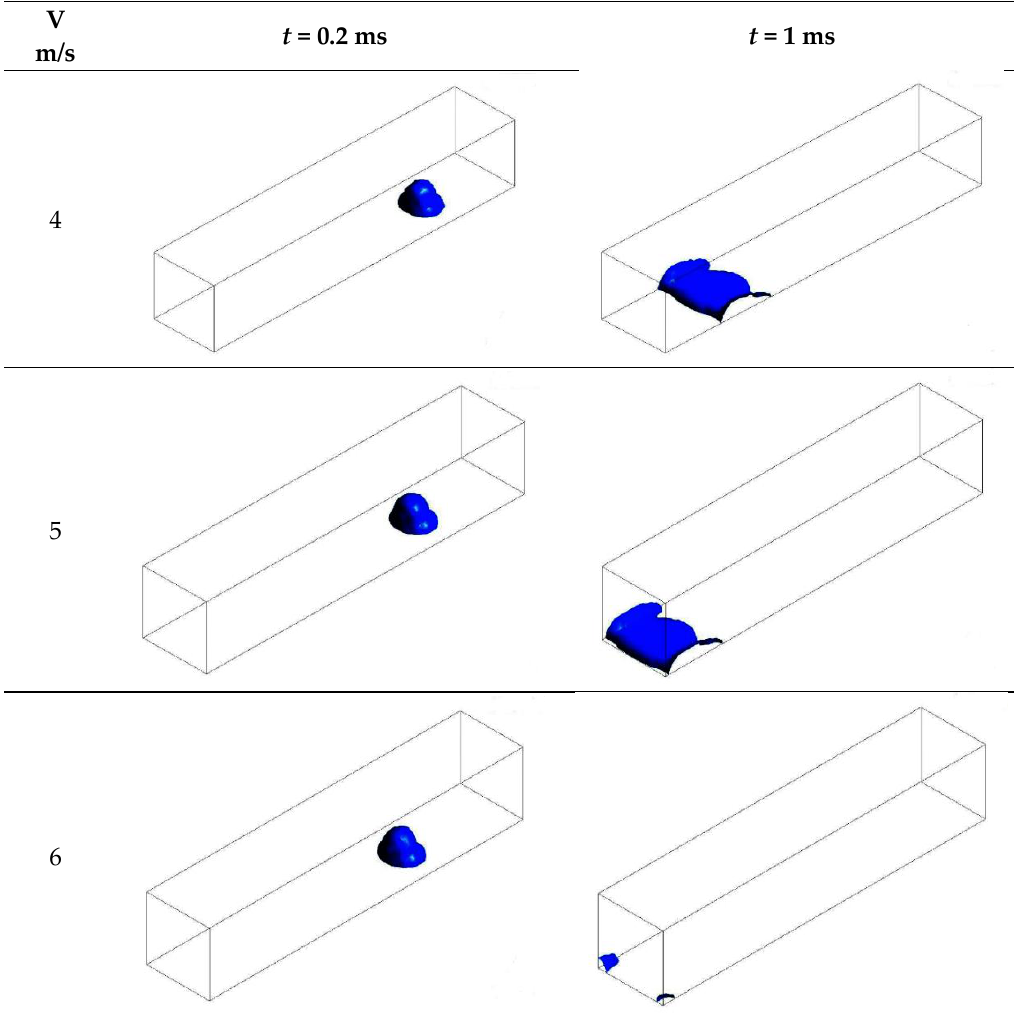
Figure 4. Water droplet behaviors at different inlet velocity (the GDL surface contact angle is 45° and the side walls contact angles are 45°).